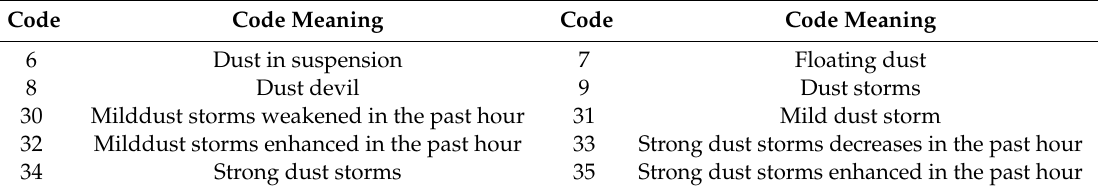
Table 5. MICAPS code for dust